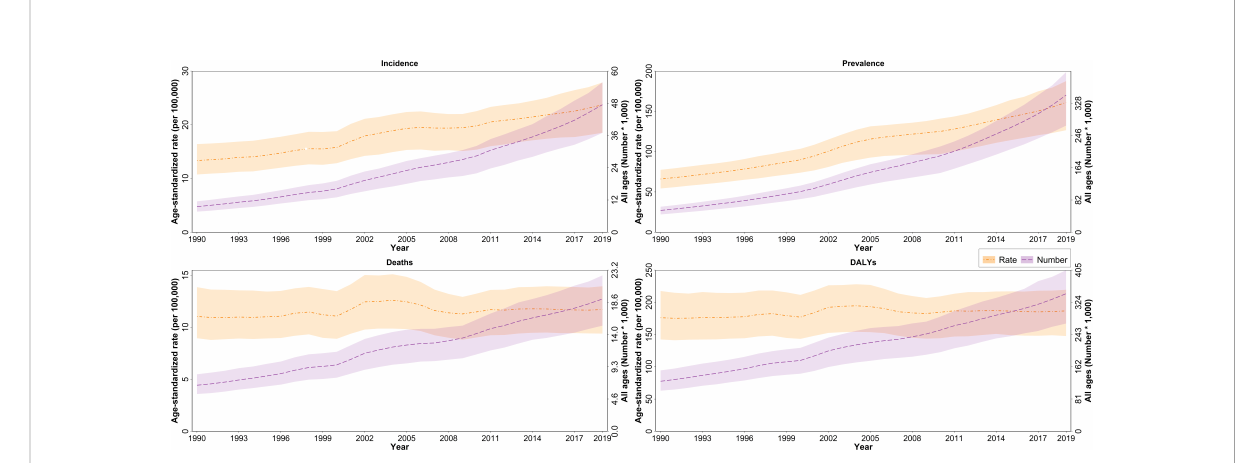
FIGURE 2 Age-standardized rates and all-ages numbers of incidence, prevalence, deaths, and DALYs due to prostate cancer in North Africa and Middle East from 1990 to